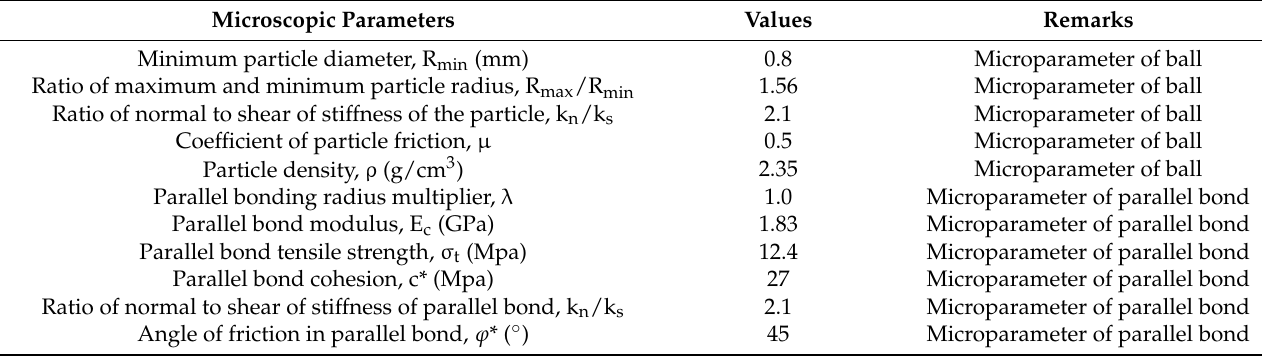
Table 5. Microscopic parameters of PFC3D